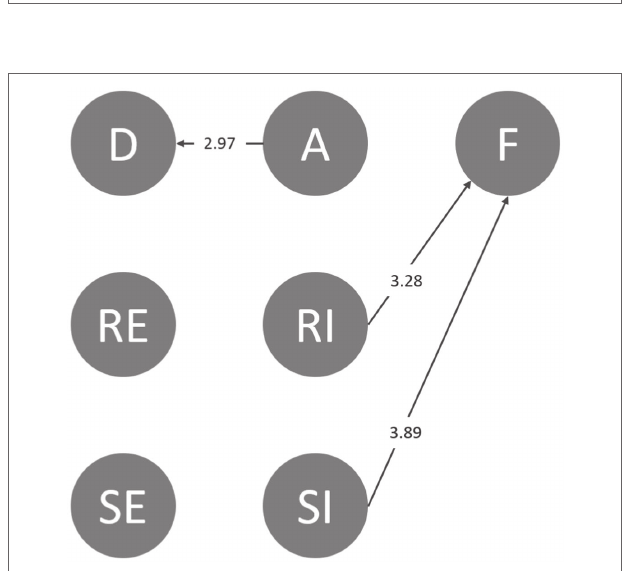
FIGURE 6 | Behavioral transition diagram of